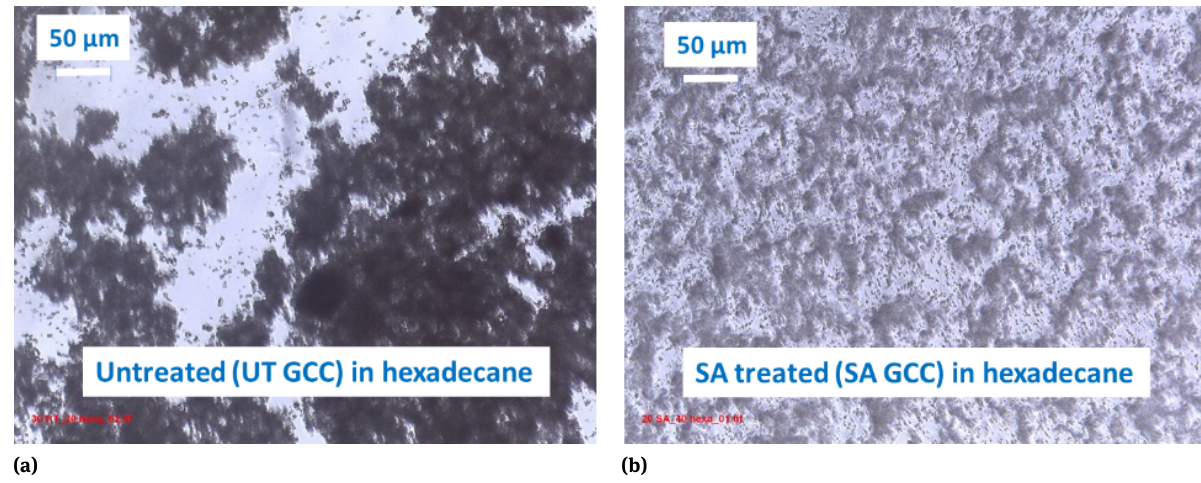
Figure 9: Optical microscope images contrasting the state of dispersion for (a) untreated and (b) surface treated (lyophilised) GCC samples dispersed in the purely dispersive liquid, hexadecane: the improved dispersion, albeit imperfect, is clearly visible.